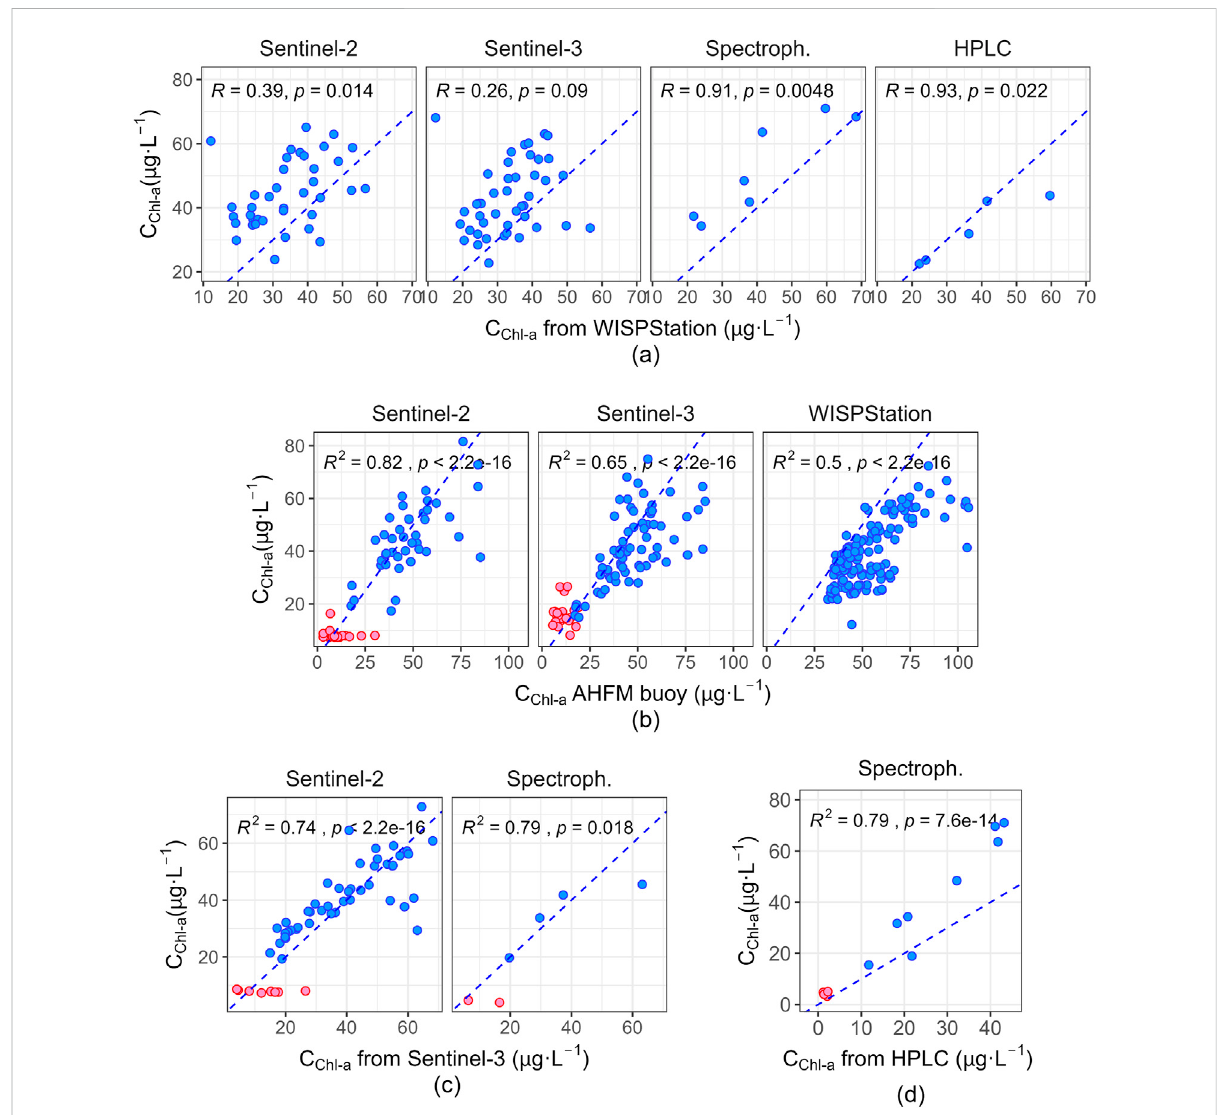
FIGURE 3 Comparison of C Chl-a (µg · L − 1 ) acquired by various methods in Võrtsjärv (blue dots) and Saadjärv (red dots): (A) C Chl-a from WISPStation in comparisonwithS2(1),S3(2),spectrophotometry(3)andHPLC(4), (B) C Chl-a from fl uorescenceincomparisonwithS3(1),S2(2)andWISPStation(3), (C) C Chl-a fromS3incomparisonwithS2(1)andspectrophotometry(2)and (D) C Chl-a fromHPLCincomparisonwithspectrophotometry.R2denotes the coef fi cient of determination about the entire